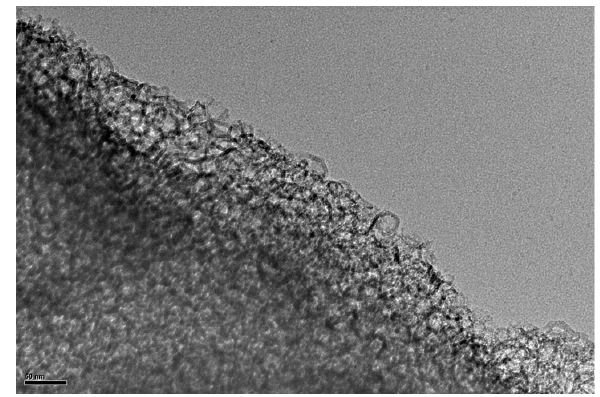
Figure A2. TEM image of mesoporous silica.